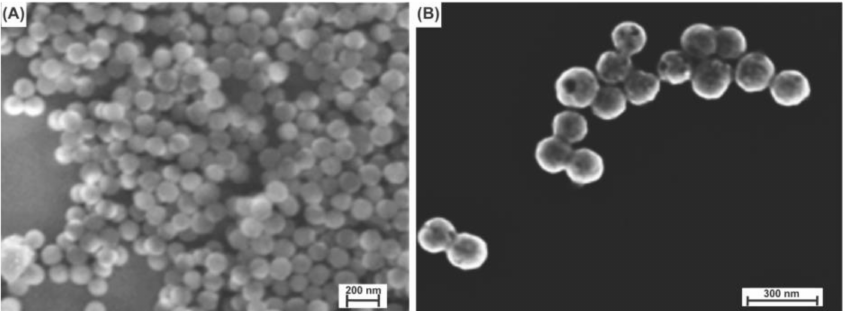
Figure 1. SEM images of ( A ) SiO 2 cores (~120 nm in diameter) and ( B ) gold nanoshells (~160 nm in diameter). The scale bars are 200 and 300 nm, respectively, where the magnified image on the right illustrates the increase in diameter arising from the gold